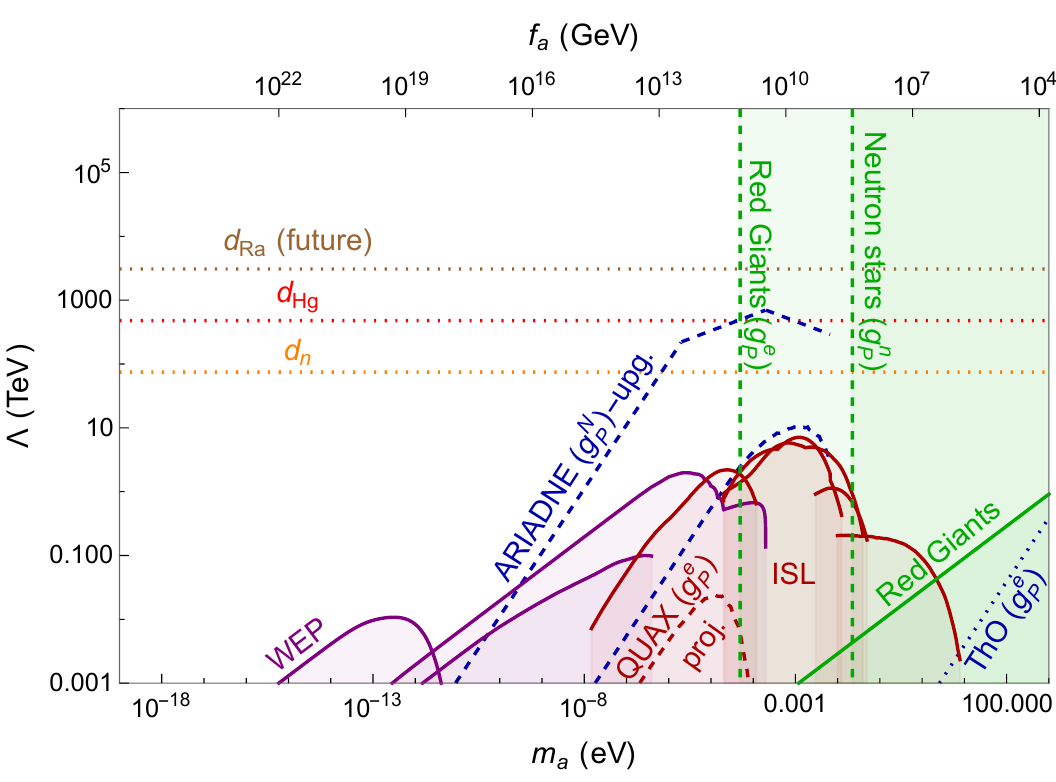
Figure 3 . Constraints on Λ from various experiments discussed in section 7. The labelling of the lines is explained in the caption of figure